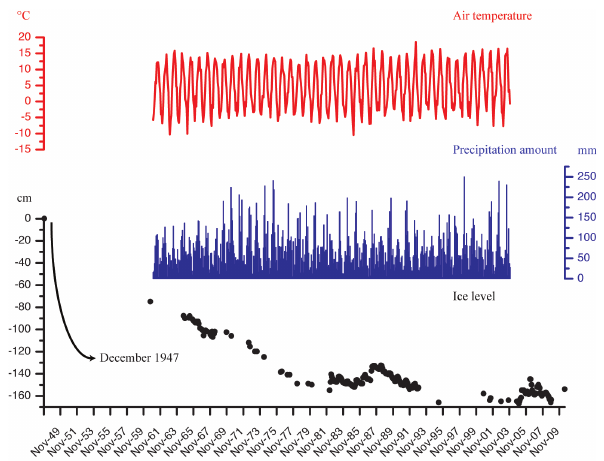
Fig. 2. Short-term ice level fluctuations in Sc˘aris¸oara Ice Cave (1947–2010, modified from Racovit¸ ˘ a, 1994b) against the air tem- perature and precipitation amount recorded at B˘ais¸oara Meteoro- logical Station